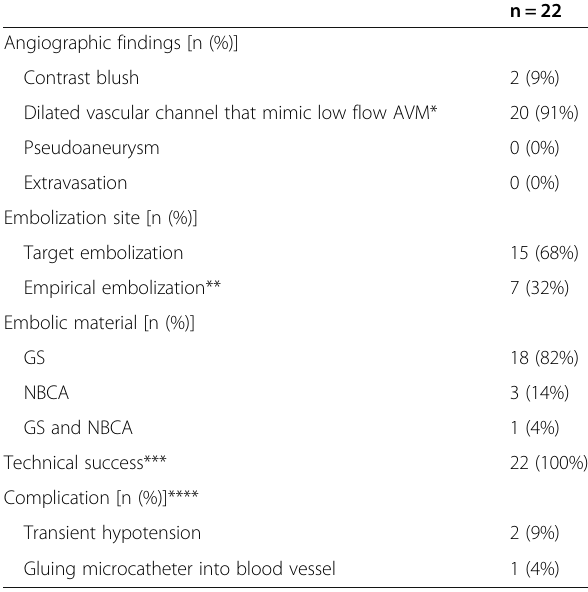
Table 2 Angiographic findings and TAE